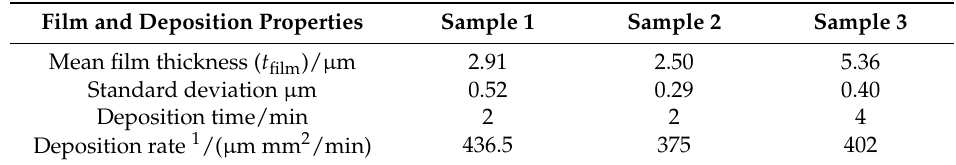
Table 3. Overview of achieved film thicknesses, deposition times, and rates. Sample 1 was analyzed by laser scanning microscopy (LSM) and Samples 2 and 3 by profilometer,